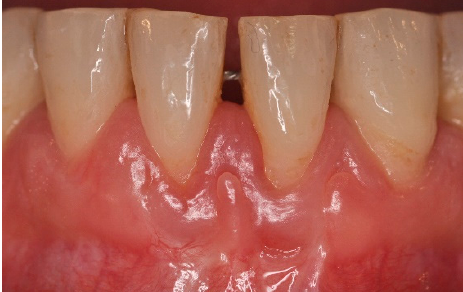
Figure 11. One-year post-operative aspect of lower anterior area. Note gingival aspect, with minimal recession compared to pre-operative aspect, increased attached and keratinized gingival width, with no frenum and muscle pull.